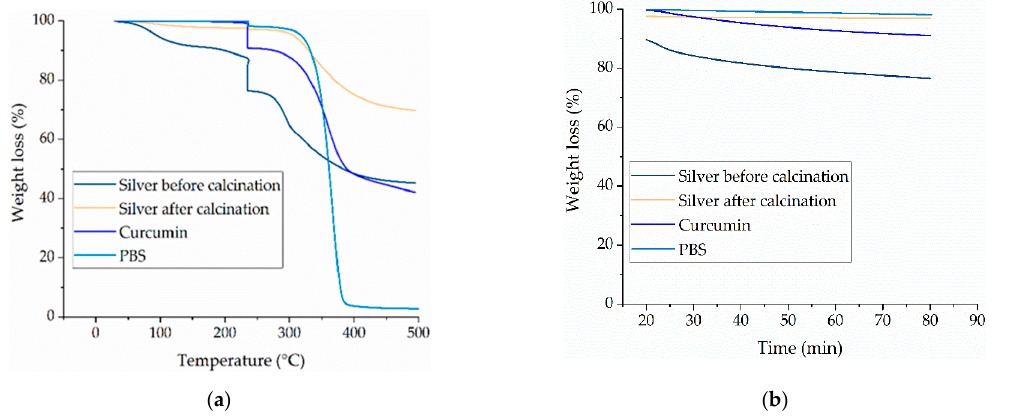
Figure 4. Thermogravimetric analysis (TGA) of the PBS base polymer and pure additives. ( a ) Temperature-dependent degradation profile of PBS, curcumin and silver (before and after calcina- tion). ( b ) Isothermal analysis of PBS, curcumin and silver nanoparticles (before and after calcination) at 235 ◦ C for 60